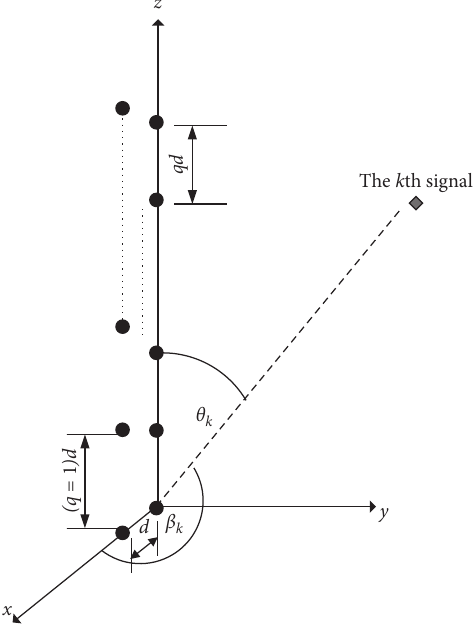
Figure 1: Construction of proposed two-parallel linear